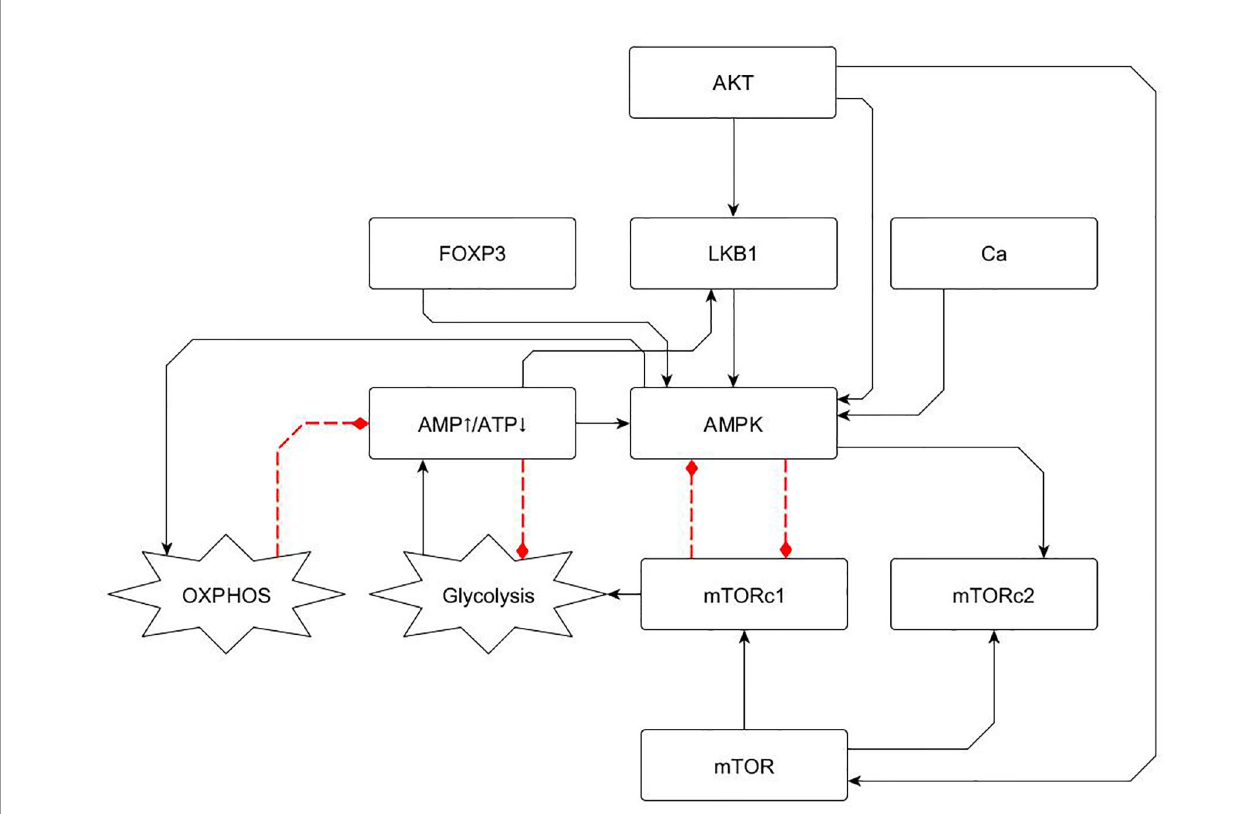
FIGURE 2 | Metabolism module including basic elements involved in glycolysis and OXPHOS regulation, as described in section 2.1. AMPK is a central energy sensor of the AMP/ATP ratio and displays a negative feedback loop with MTORC1. This loop de fi nes a switch driving either OXPHOS or glycolytic activity. Continuous and dotted lines represent activator and inhibitory pathways,